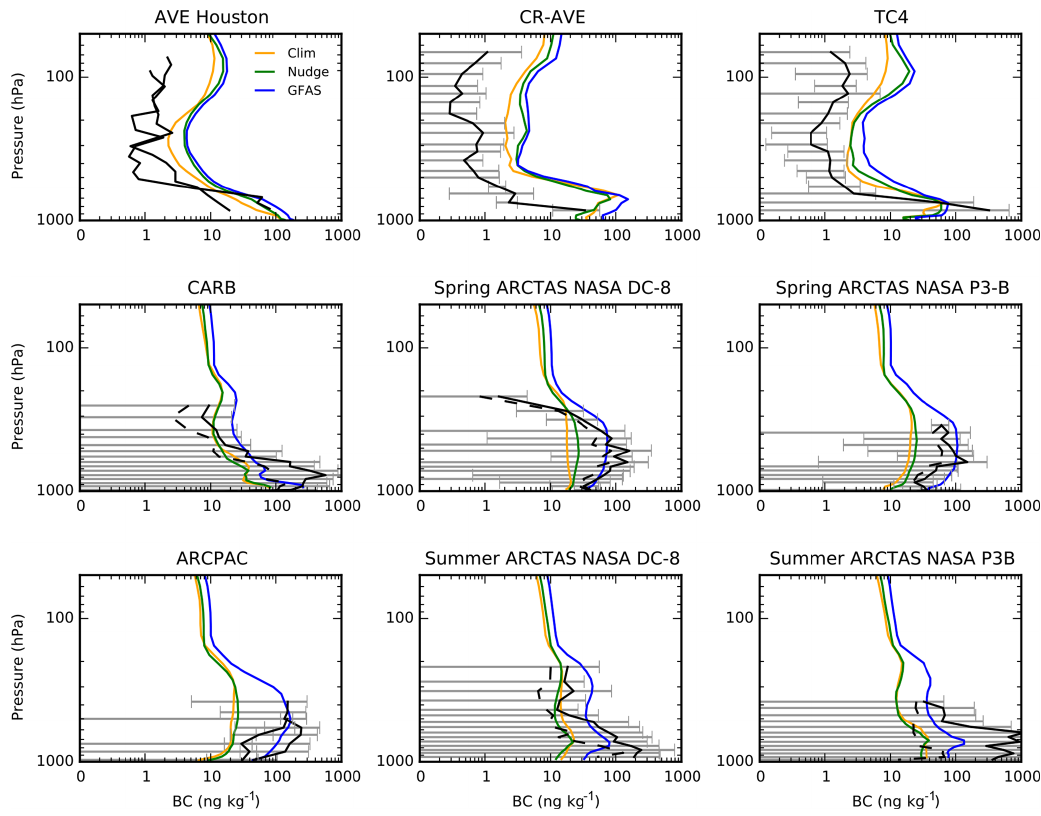
Figure 14. Vertical profiles of observed concentrations of BC (black) and collocated simulated concentrations from the three simulations: CLIM (orange), NUDGE (green), and GFAS (blue). The observations are provided for nine locations and seasons (see Fig. 2) (Koch et al., 2009). Observations are averaged for the respective campaigns (standard deviations are provided where available) and mean (solid black) and median (dashed black) profiles are shown for some campaigns. Model outputs (monthly averages) are sampled over specific points in each